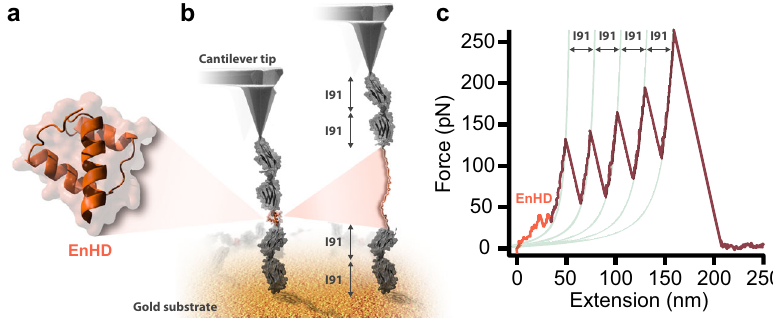
Fig. 1 Single-molecule force-extension experiments. a Representation of the crystal structure of the EnHD domain. b Scheme of the experimental setup. The EnHD is sandwiched between two titin homodimers, deposited in solution over a gold surface, and dragged by the AFM cantilever, resulting in the unfolding of the proteins. c Force-extension trace including the characteristic sawtooth pattern for the titin domains, and the initial featureless signal for EnHD. Stretching is conducted at a speed of 40 nm s − 1